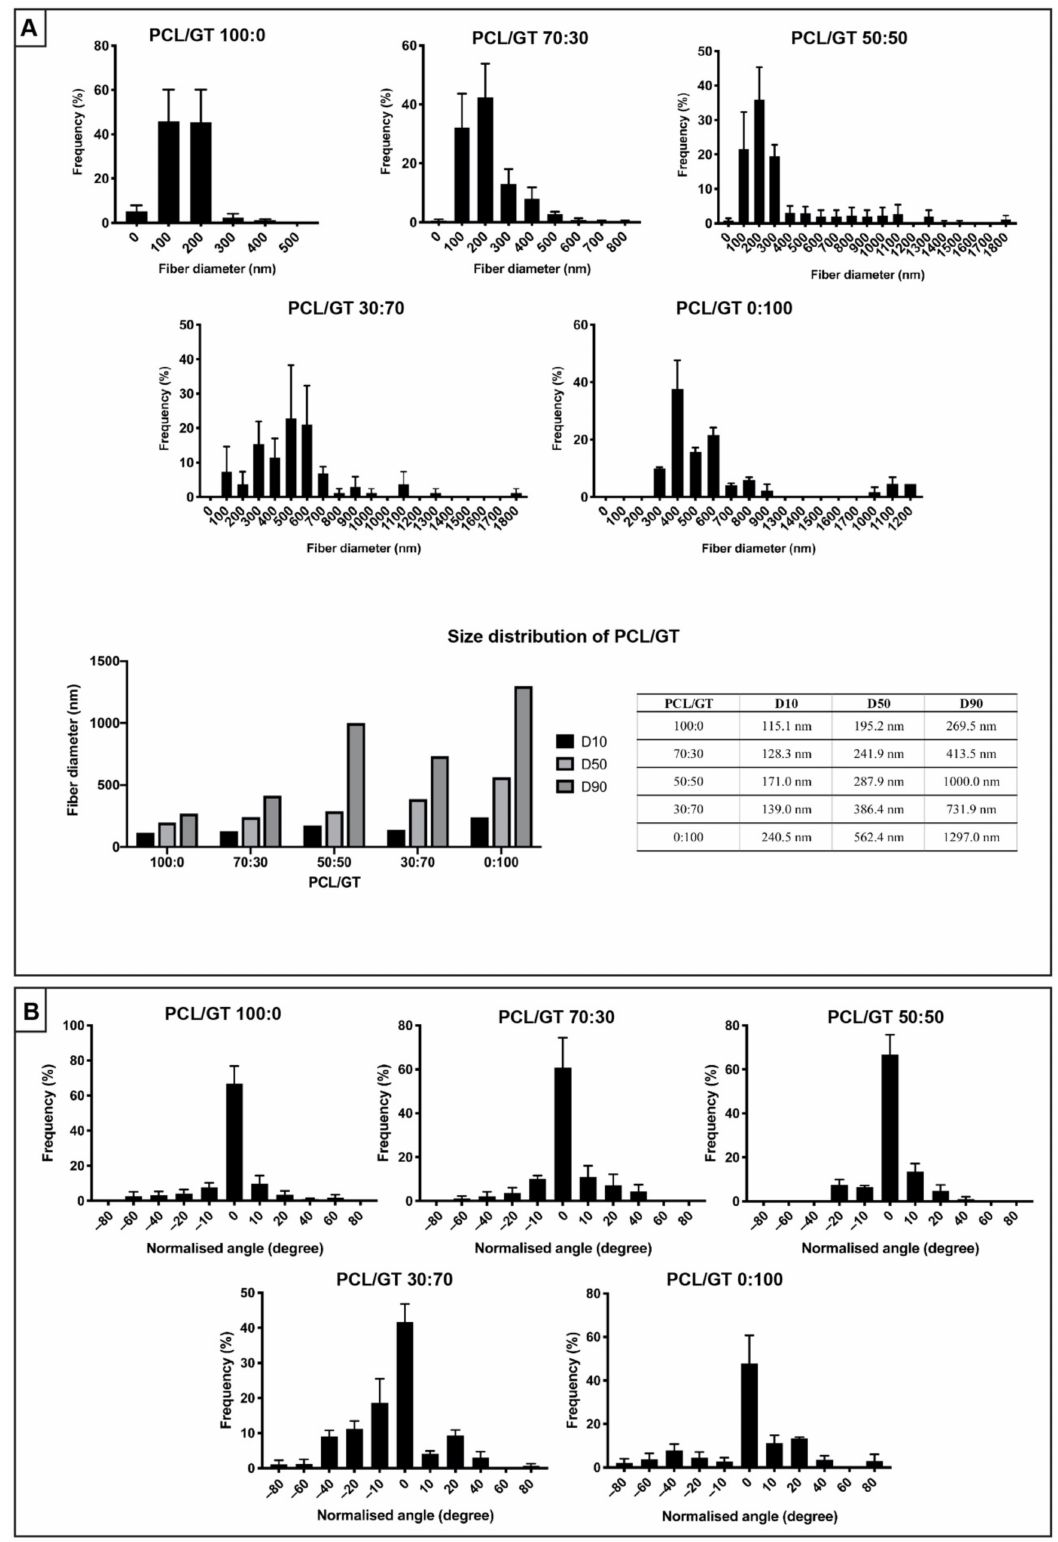
Figure 2. ( A ) The diameter and size distribution of PCL/GT nanofibers. Note that increasing GT concentration will increase the fiber diameter. ( B ) The fiber alignment of PCL/GT nanofibers. All nanofibers were relatively aligned, as indicated at the 0 ◦ normalized